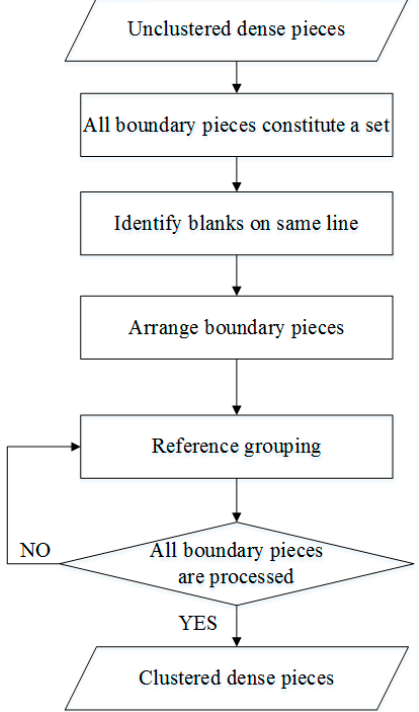
Figure 15. Flowchart of BSL (blanks on the same line) algorithm. Appl. Sci. 2017 , 7 , 951